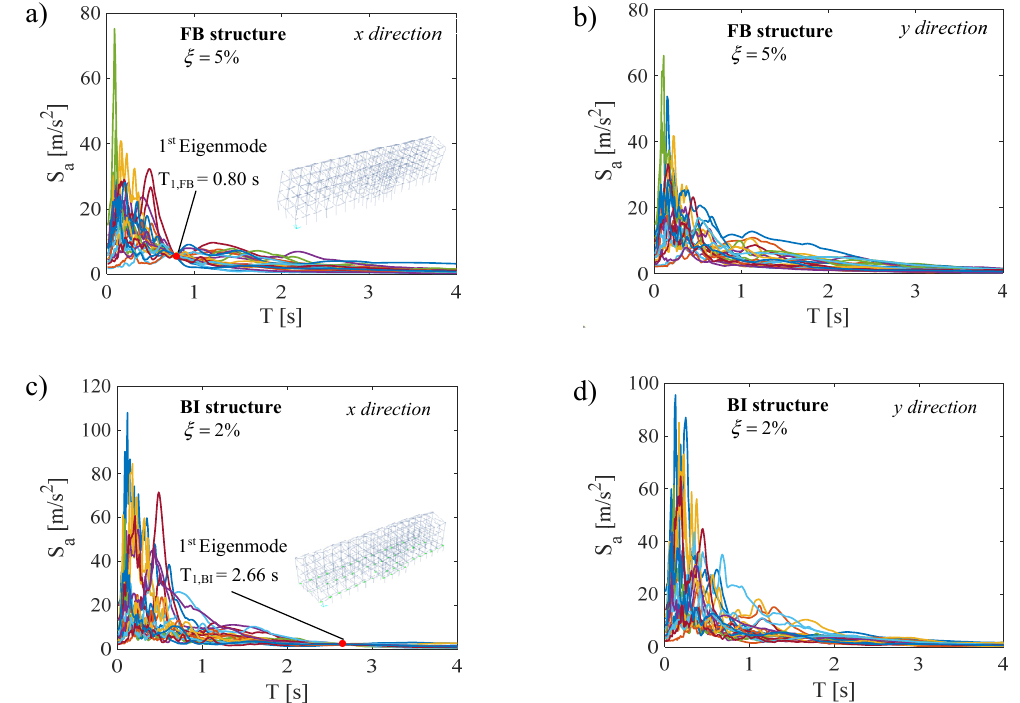
Figure 8. Scaled acceleration spectra for FB ( a , b ) and BI ( c , d ) structure of the 21 real ground motion records in X direction ( a , c ); Y direction ( b , d ).